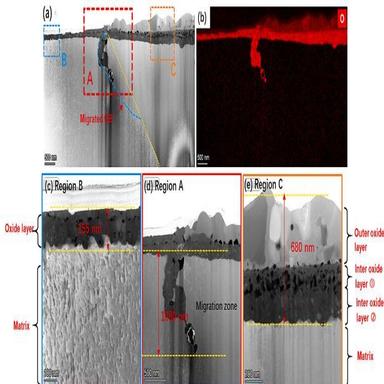
(a) TEM HAADF image of the oxide scale (TEM sample 2 in after exposure in SCW at 600 ◦C for 1000 h, (b) O element EDS mapping data, showing the thickness of the oxide scale, (c-e) the TEM HAADF images with higher magnification of Region B, A and C framed in (a).